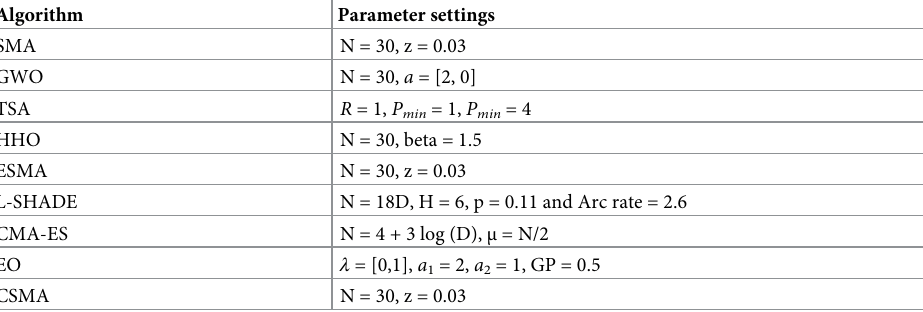
Table 4. Algorithms-specific parameter settings.